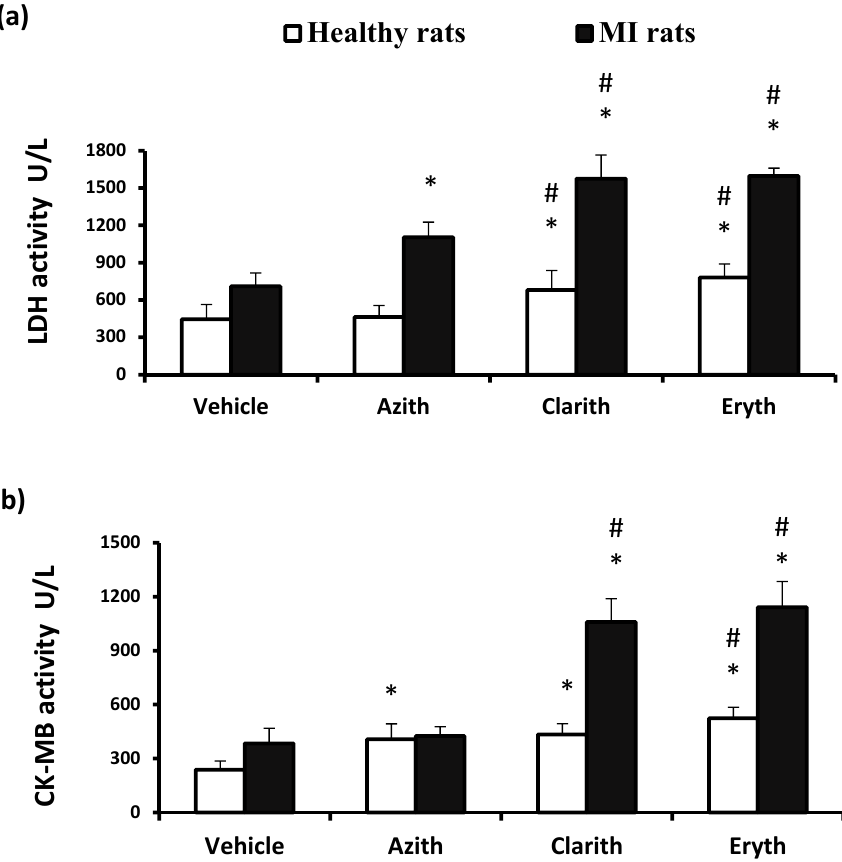
Figure 1. Serum cardiac enzyme activities in the rat experiments. ( a ) LDH activity and ( b ) CK-MB activity in healthy or MI rats treated with azithromycin (Azith), clarithromycin (Clarith), or erythromycin (Eryth). MI: myocardial infarction, LDH: lactate dehydrogenase, CK-MB: creatinine kinase—myocardial band. Data in each set were presented as mean ± standard deviation, and analyzed separately by one-way ANOVA and Bonferroni’s test. * Different from the vehicle group at p -value less than 0.05. # Different from the azithromycin group of the same experiment at p -value less than 0.05 ( n = 4– 6).